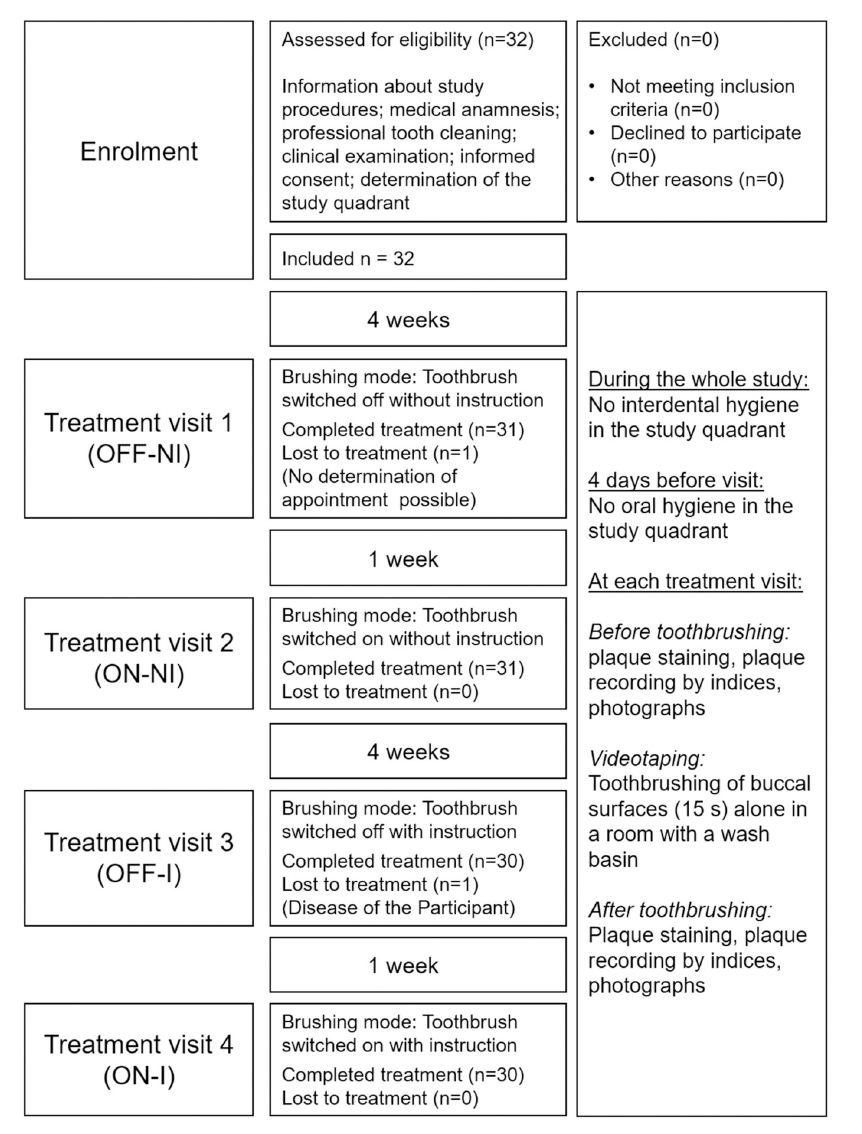
Fig 1. Flow chart of study